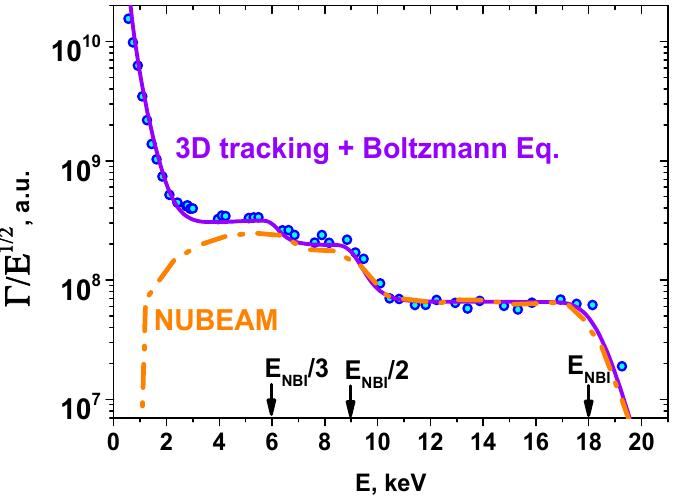
Figure 9. CX spectra measured by NPA (blue dots), discharges ##32990–32998, and simulated ones using fast ion distribution calculated by NUBEAM (orange dash-dot line) and 3D tracking algorithm combined with the solution of the Boltzmann kinetic equation (violet solid line). The figure is taken from [46] and reproduced with permission from IOP